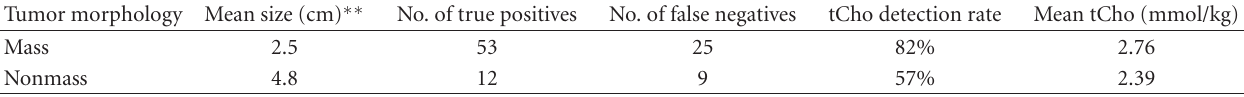
Table 1: Summary of tumor size, tCho detection rate, and tCho concentration level in morphological types. Tumor morphology Mean size (cm) ∗∗